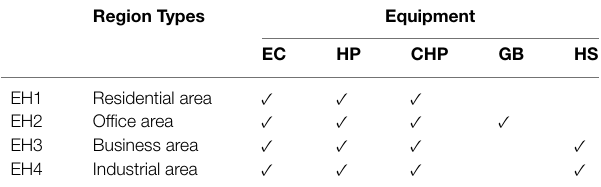
TABLE 2 | Region type and the configuration of EHs.